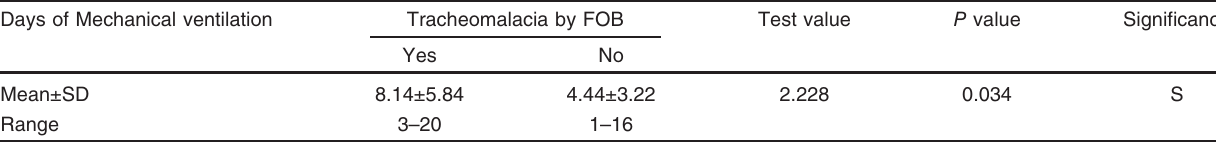
Range 3 – 20 1 – 16 FOB, fiberoptic bronchoscopy; S,